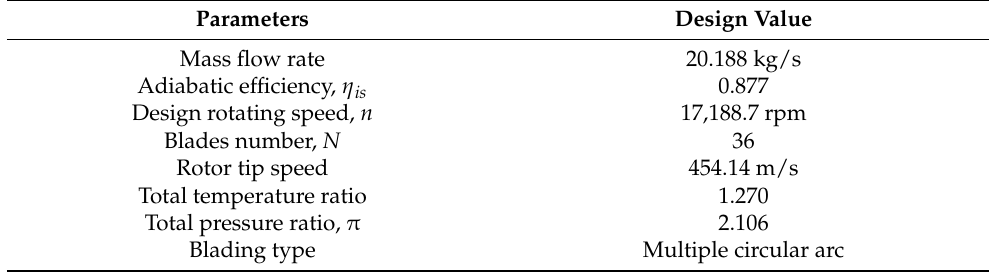
Figure 1. NASA rotor 37 cross − section and span plane. Table 1. Parameters of the model.